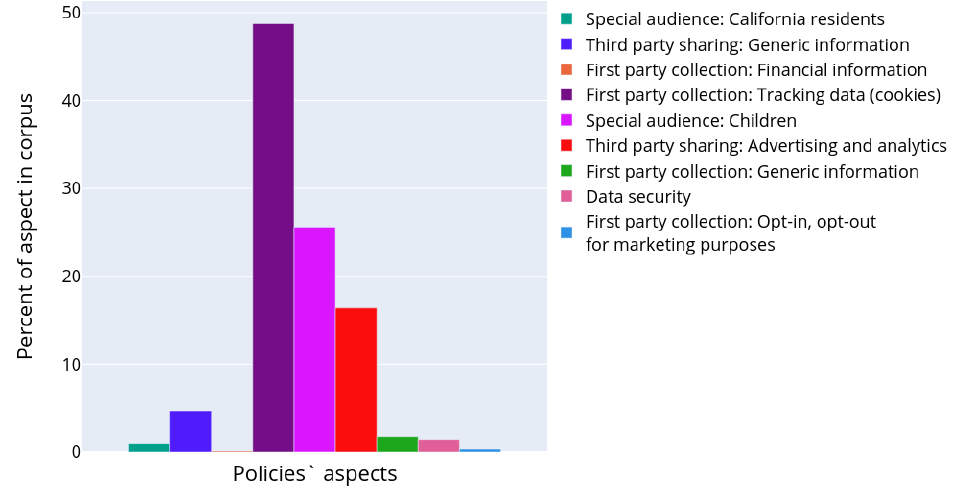
Figure 10. Distribution of various topics describing personal data usage scenarios in the OPP-115 corpus of documents.